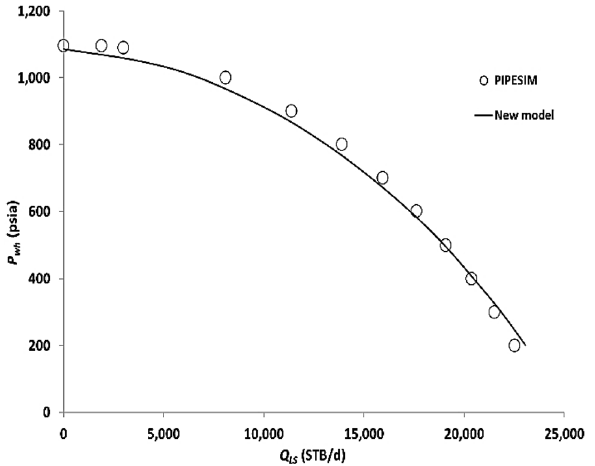
Fig. 6 Comparison of models for well